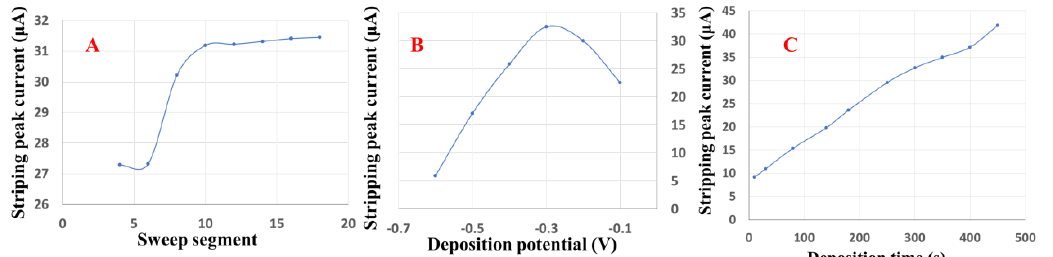
Figure 5. The effects of ( A ) the number of sweep segments, ( B ) the deposition potential and ( C ) the deposition time on the As(III) stripping peak currents on rGO-Au nano /GCE in a 0.1 M HNO 3 solution containing 15 μg/L As( III).